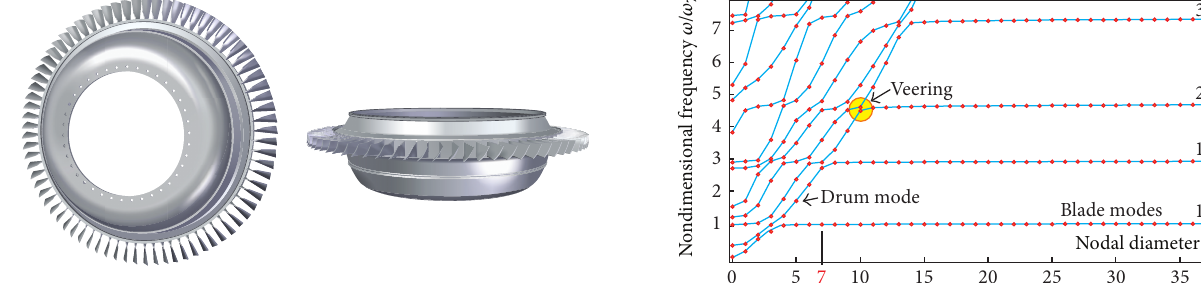
Figure 2: Natural frequencies (normalized to 𝜔 7 ) versus nodal diameters 𝑛 for the bladed drum of Figure 1 (for a given rotation speed Ω ).